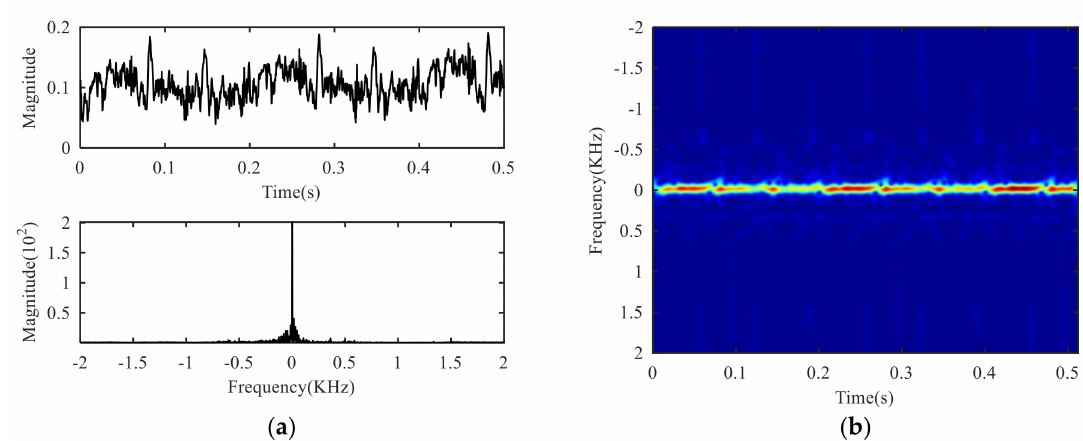
Figure 5. Experimental signal: ( a ) Time domain and frequency domain, ( b ) time-frequency domain.